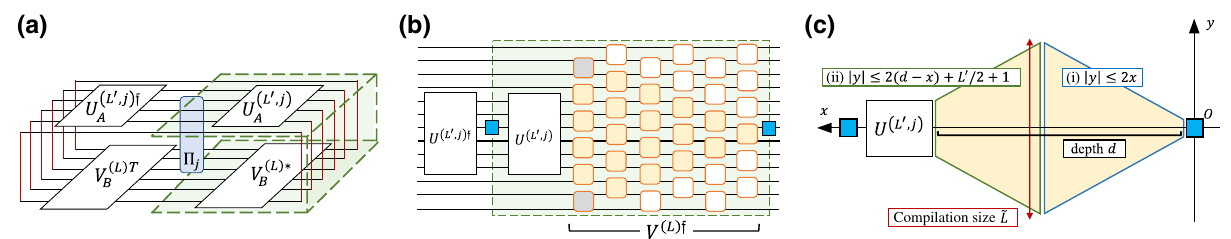
(cid:16) , j ) , V ( L ) )) . This gives an approximate upper bound of the local cost function ρ ( U ( L (cid:16) , j ) , V ( L ) )) , designated by the green region in (a). Only j AB